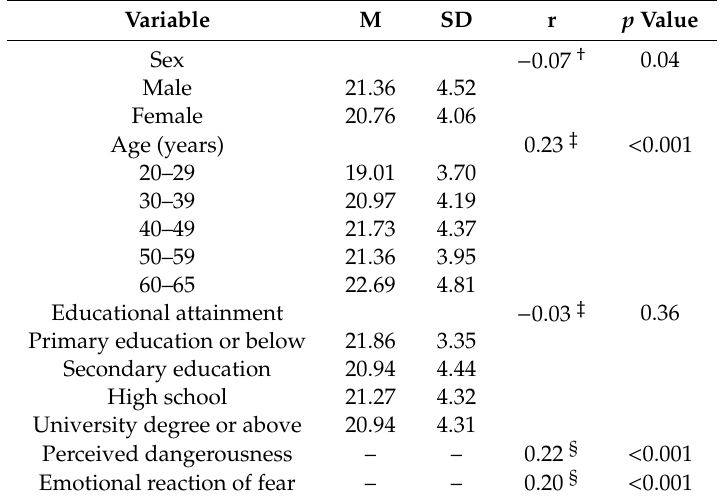
Table 2. Bivariate correlation analysis of individual-level variables and social distance.